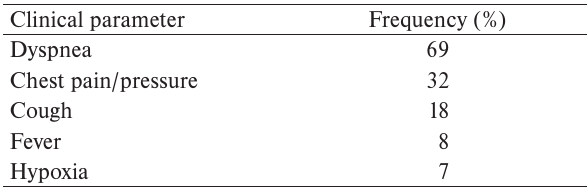
Table 4. Presence of other clinical symptoms not included in sGS according to CTPA request forms.